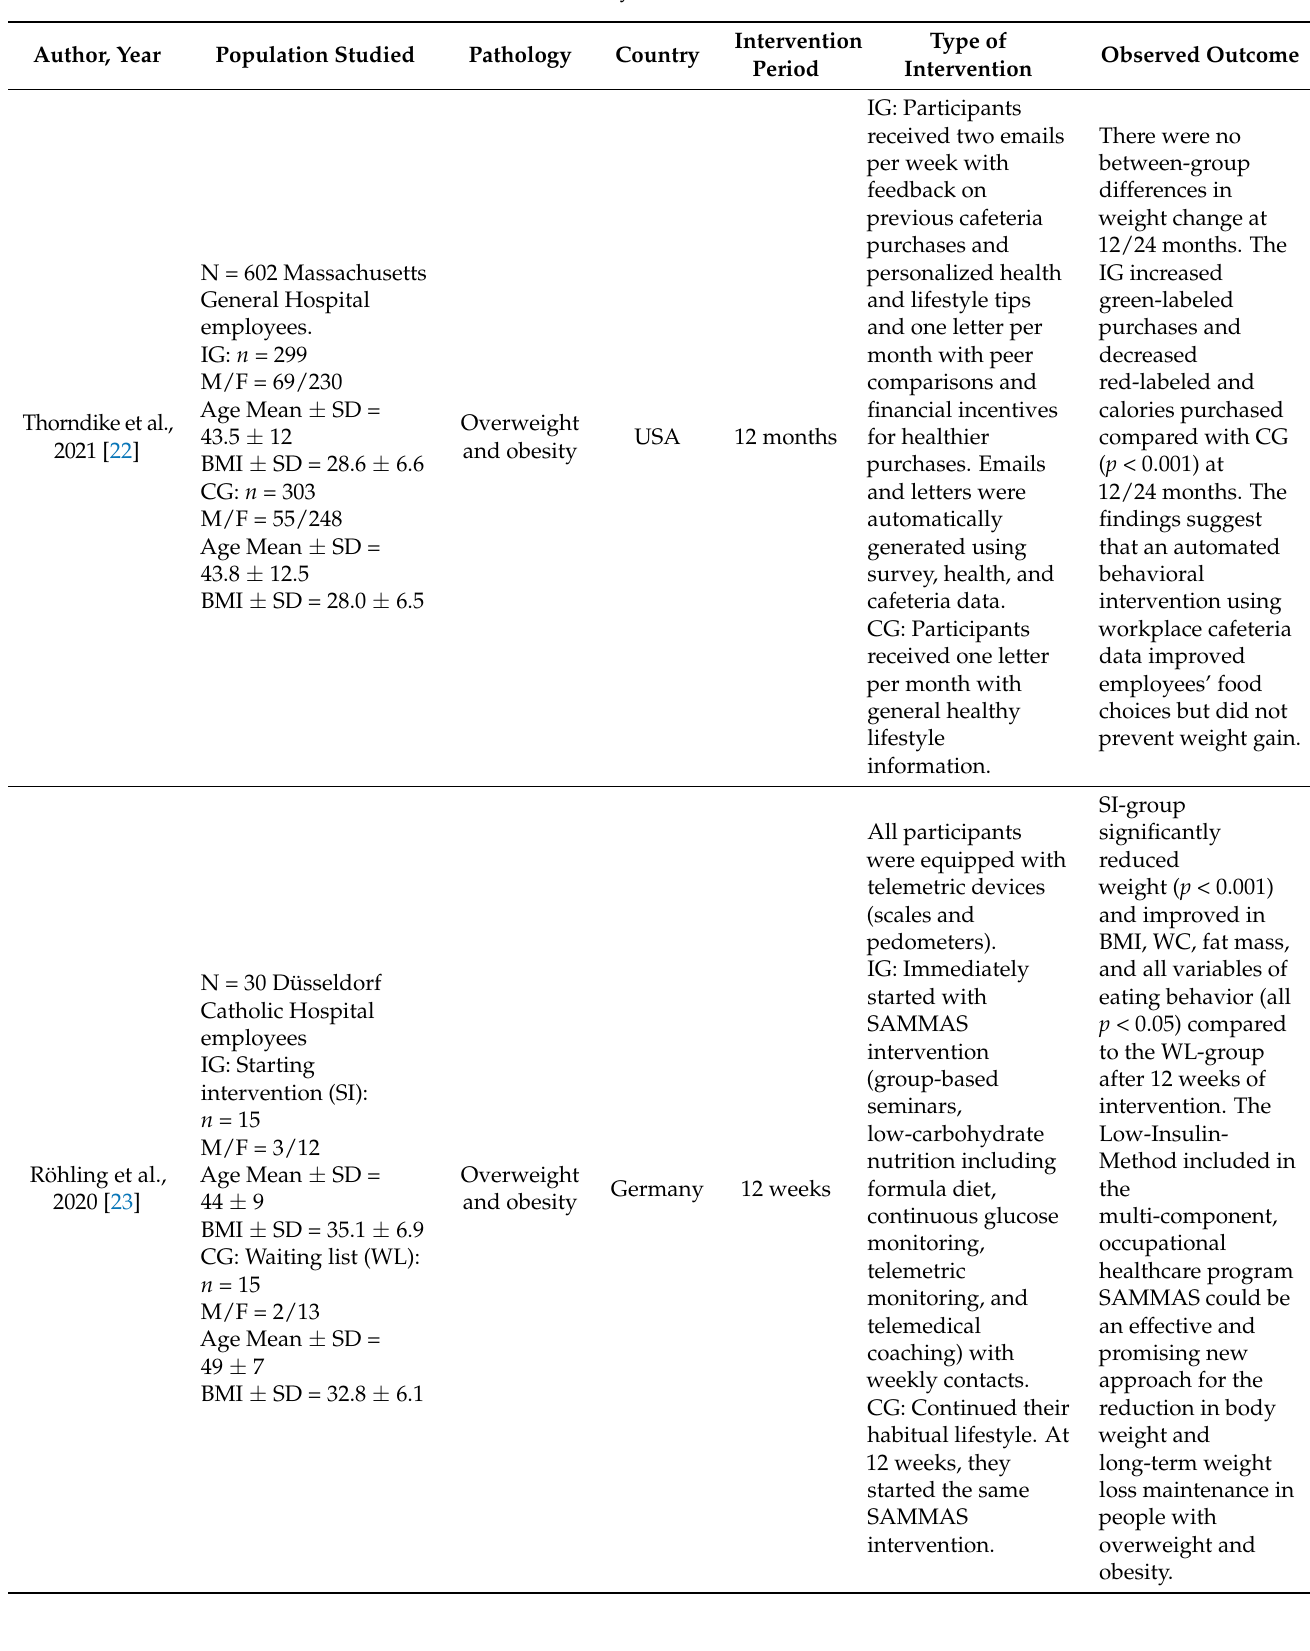
Table 1. Summary of the studies